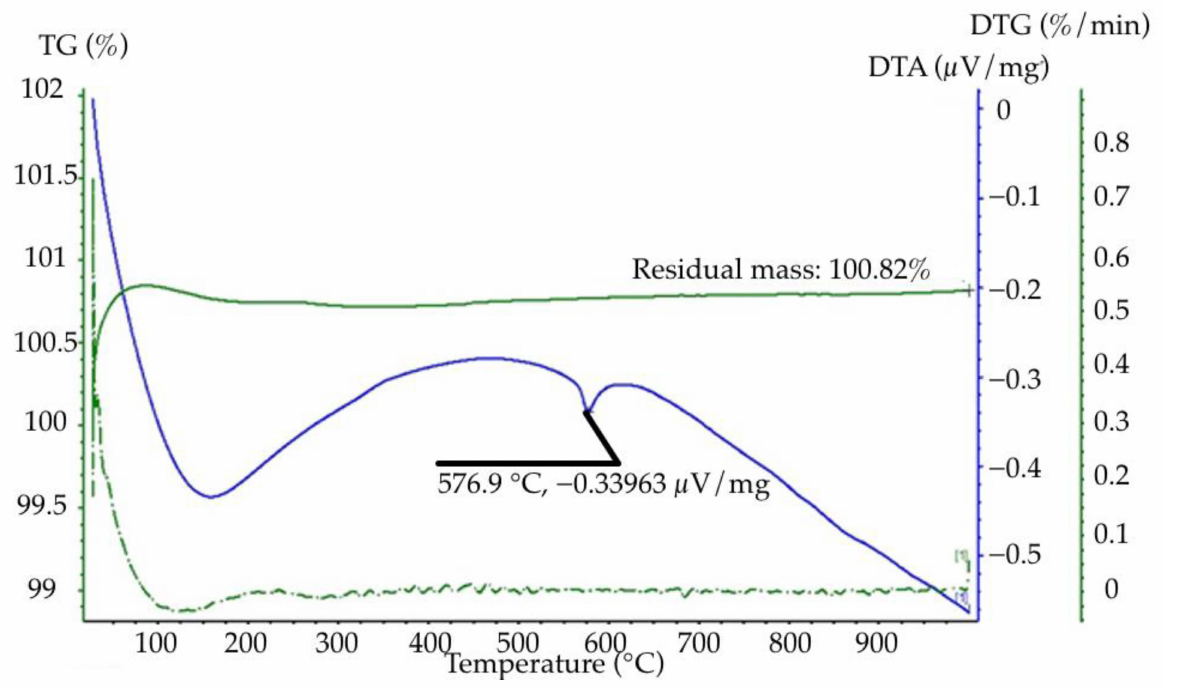
Figure 6. Derivative of a quartzite heated to 1000 ◦ C: DTA-Ich curve from temperature; TG- Thermogram curve showing mass reduction; DTG-Thermogram curve indicating mass increase, which may occur due to the oxidation